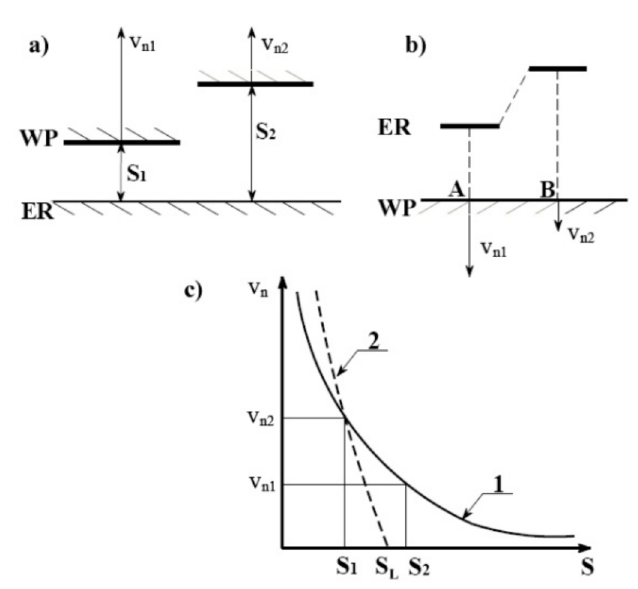
Figure 3. Scheme of the ECM localization idea for flat tip electrode ( a ) and shaped electrode ( b ) (WP— workpiece surface, ER—electrode surface); ( c ) relation of dissolution velocity v n ( S ) to interelectrode gap size S ( S L —limiting interelectrode gap thickness)